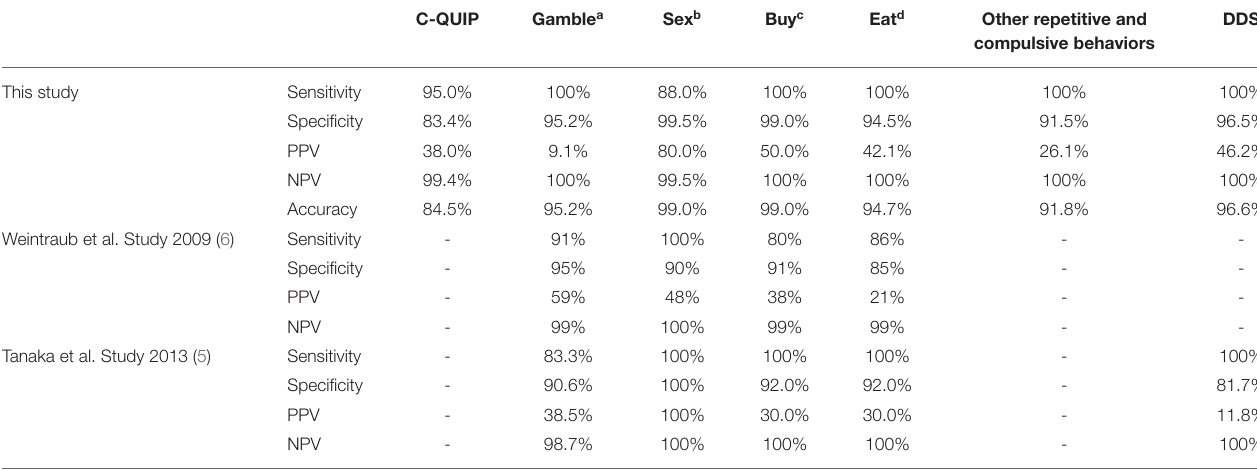
TABLE 2 | The sensitivity, specificity, positive predictive value, negative predictive value of